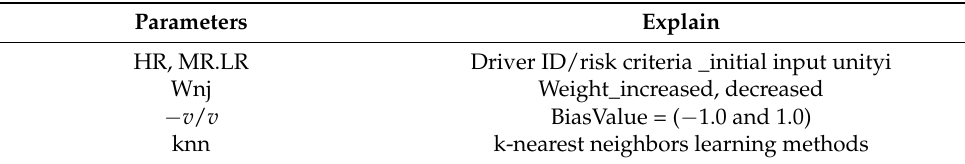
Table 5. DDP deep learning model parameters.